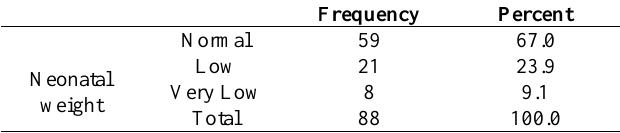
Table 1: classification of neonatal